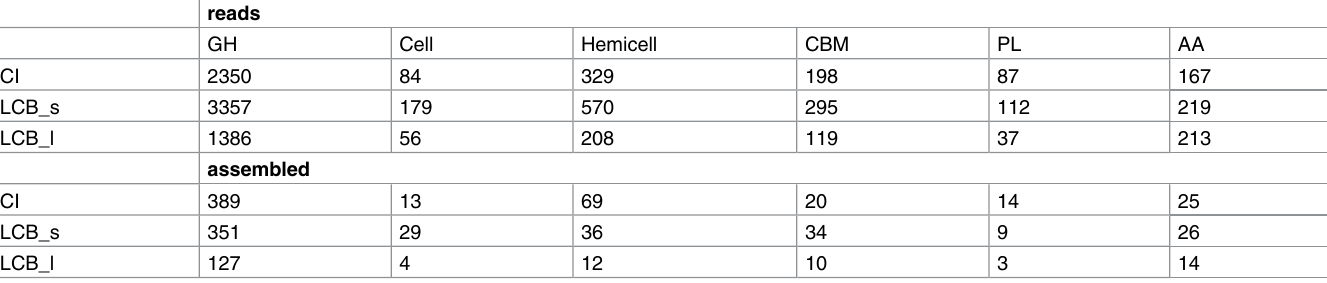
Table 4. Number of CAZyme hits on individual reads and assembled